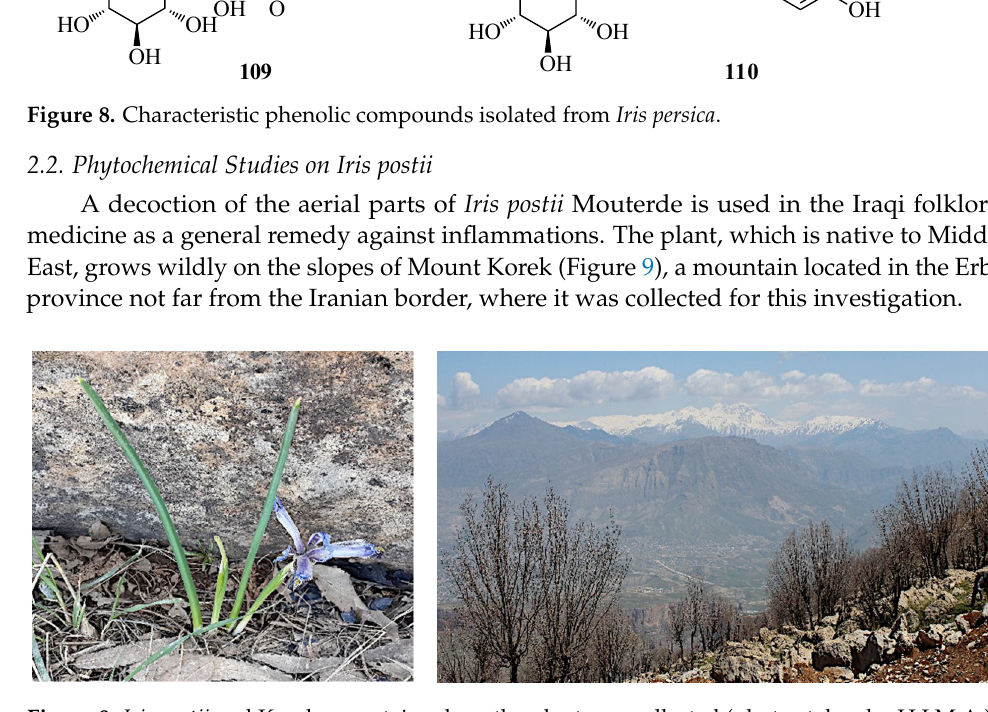
Figure 9. Iris postii and Korek mountain where the plant was collected (photos taken by H.I.M.A.).